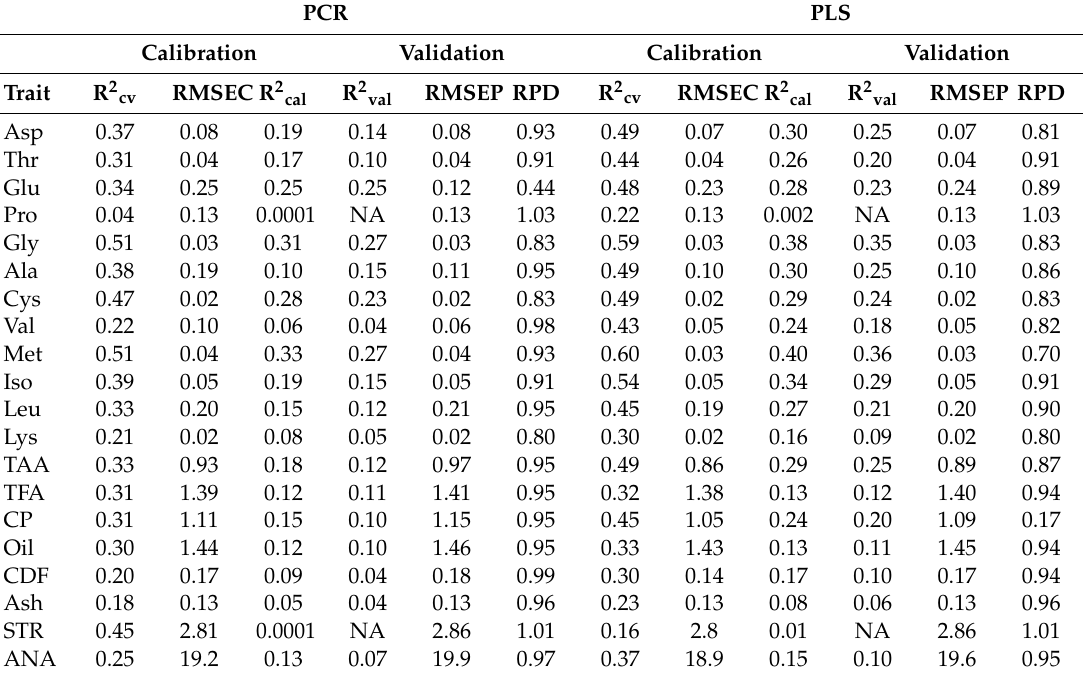
Table 4. PCR and PLS model results of calibration and validation for twenty di ff erent constituents (0th derivative). Coe ffi cient of determination (R 2 ) of actual (R 2 cal ) and predicted (R 2 val ) constituent values. Ratio of performance to the standard deviation (RPD).